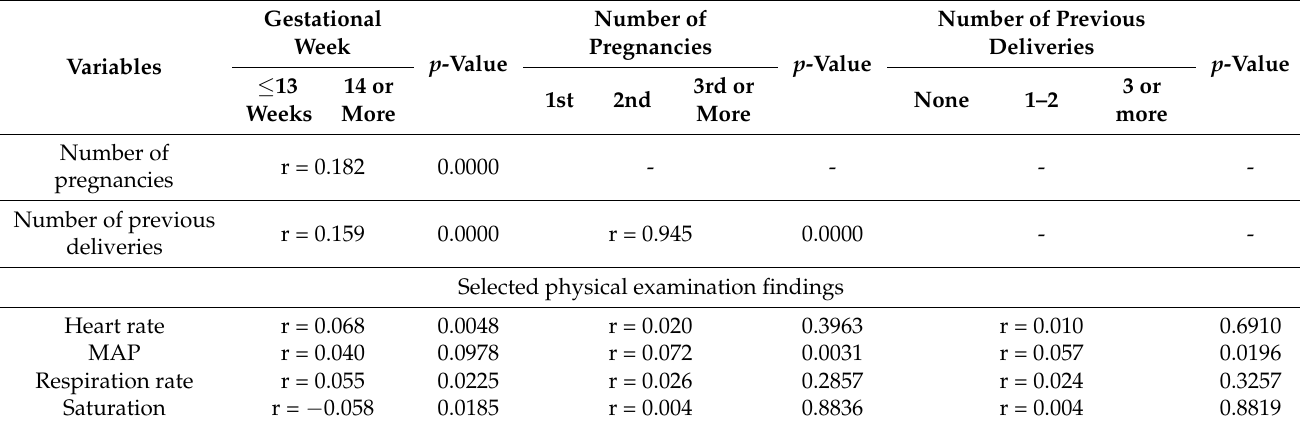
Table 5. Analysis of the correlation between gestational week, number of pregnancies and number of previous deliveries and selected